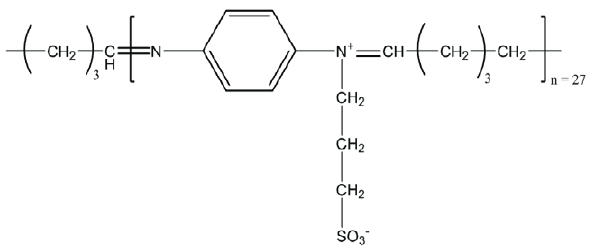
Figure 3. The chemical structure of the pseudo zwitterionic poly- mer studied here, as quoted in 34 .